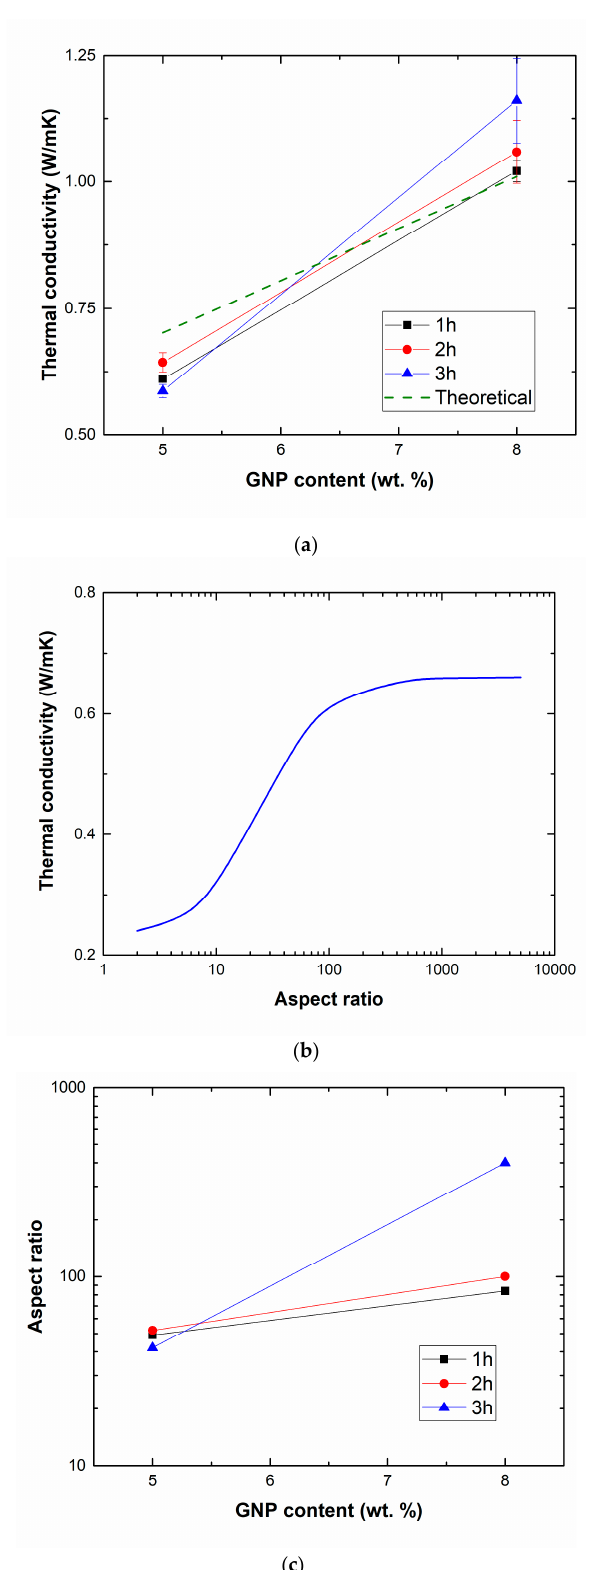
Figure 4. ( a ) Thermal conductivity measurements and theoretical estimations (dashed line), ( b ) variation of thermal conductivity for a 5 wt.% GNP sample accordingly to Hatta et al. model [40] as a function of GNP aspect ratio, and ( c ) estimation of aspect ratio accordingly to Hatta model for the different conditions.